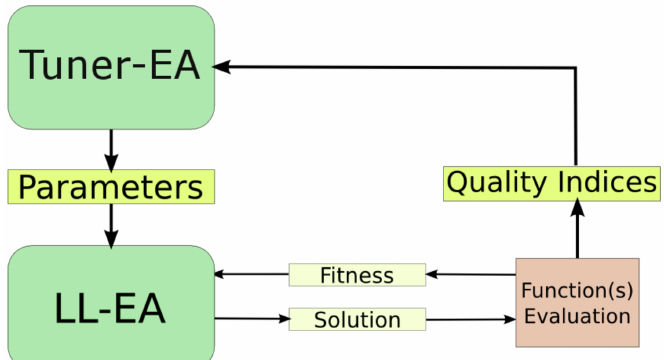
Figure 2. Scheme of SEPaT/EMOPaT. The lower part represents a classical EA. In the meta-optimization process, each individual of Tuner-EA represents a set of Parameters. For each set, the corresponding instance of the lower-level EA (LL-EA) is run N times to optimize the objective function(s). Quality indices (one for SEPaT, more than one for EMOPaT) are values that provide a global evaluation of the results obtained by LL-EA in these